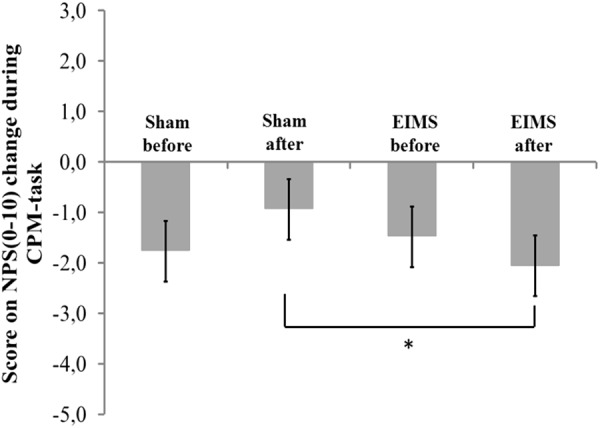
The change in NPS (0–10) during CPM-task, at baseline before intervention and in the end of treatment in the two experimental groups. The error bars indicate standard error of the mean. Asterisk (∗) indicates differences between the sham and EIMS groups. All comparisons were performed by a mixed analysis of variance model, followed by the Bonferroni test for post hoc multiple comparisons. Numerical Pain Scale (NPS0–10).